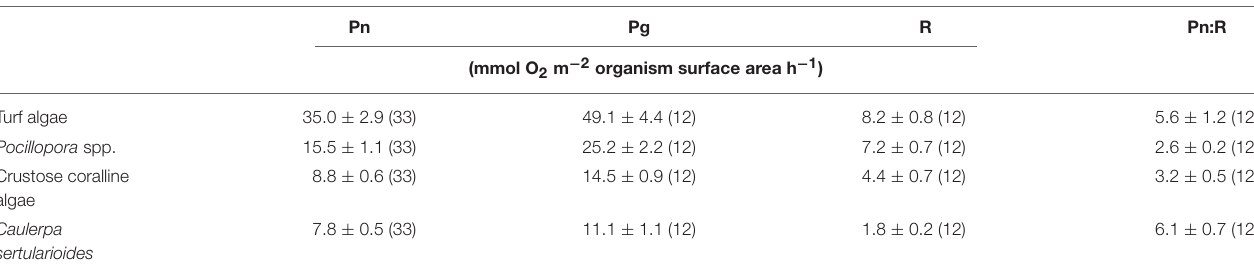
TABLE 2 | Individual primary production and respiration rates of the dominant benthic primary